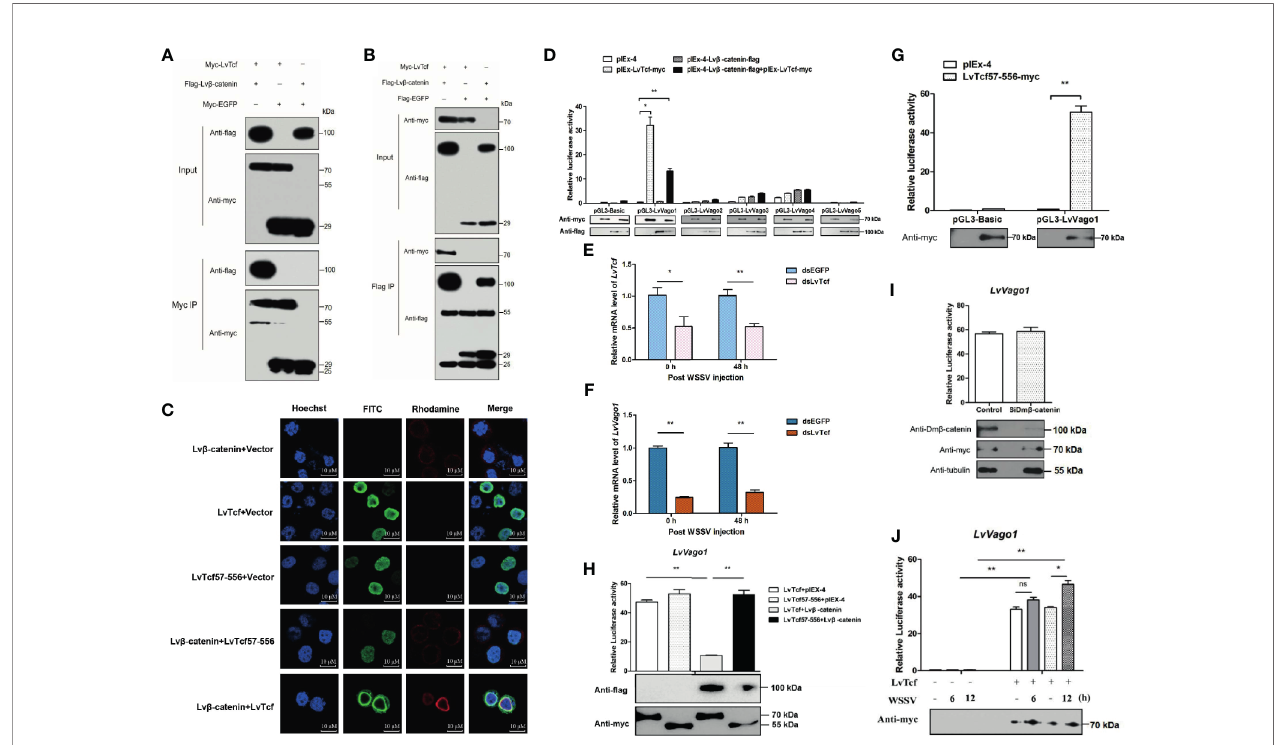
FIGURE 2 | LvTcf was involved in regulating LvVago1 expression independently of Lv b -catenin. (A, B) Co-IP analysis in High Five cells indicated that LvTcf interacted with Lv b -catenin. Cell lysates were immunoprecipitated using rabbit anti-c-Myc agarose af fi nity Gel (A) or mouse anti-FLAG M2 af fi nity gel (B) . (C) Immuno fl uorescence analysis revealed that LvTcf colocalized with Lv b -catenin. Cells were transfected with Myc-LvTcf, FLAG-Lv b -catenin, or both. After 36 h, immuno fl uorescence analysis was performed with primary mouse anti-Myc, rabbit anti-FLAG, as well as secondary FITC anti-mouse and rhodamine anti-rabbit antibodies. Finally, the cells were observed under a confocal laser-scanning microscope. The scale bar = 10 m m. (D – I) LvTcf activated the LvVago1 promoter independently of Lv b -catenin. (D) The effects of Lv b -catenin/LvTcf expression on the promoter activity of LvVago1-5 were analyzed via a dual-luciferase reporter assay. (E, F) Silencing of LvTcf led to a decrease in LvVago1 expression after WSSV infection. (G, H) The effect of LvTcf57-556/Lv b -catenin on the promoter activity of LvVago1 was analyzed via a dual-luciferase reporter assay. (I) Knockdown of Dm b -catenin did not affect the LvTcf-induced activation of LvVago1 promoter activity. (J) The effect of LvTcf on LvVago1 upon WSSV stimulation. Data were analyzed via the student ’ s t -test (ns, No Signi fi cant, *p < 0.05, ** p <